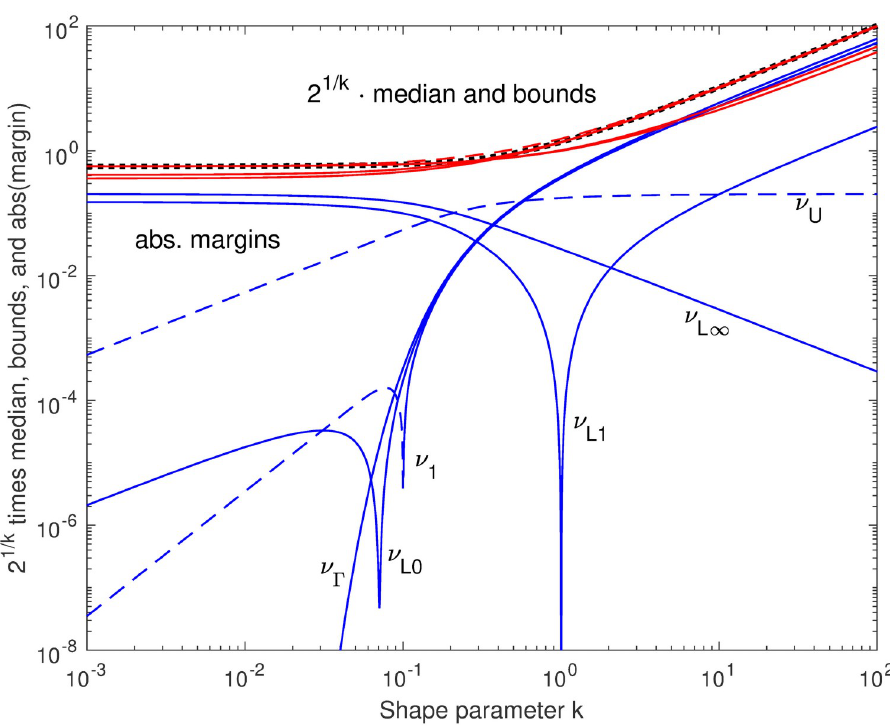
, ν , and ν (solid), and L 0 L 1 L 1 and ν have cusps (on the L 0 L 1